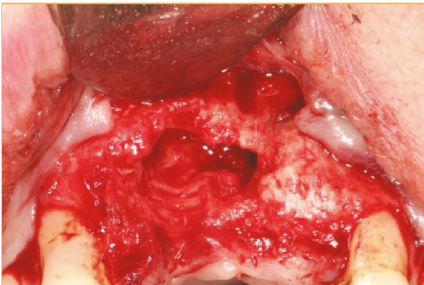
Figure 10: The xenograft was easily debrided from the osteotomy site to display the very patent aberrant canal present between the nasopalatine duct and the aberrant vascular canal.